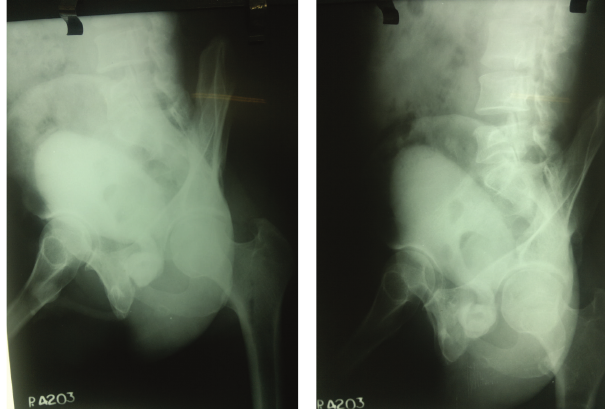
Figure 3: Micturating cystourethrogram showing stricture in the bulbar urethra and a calculus in proximal prostatic urethra.